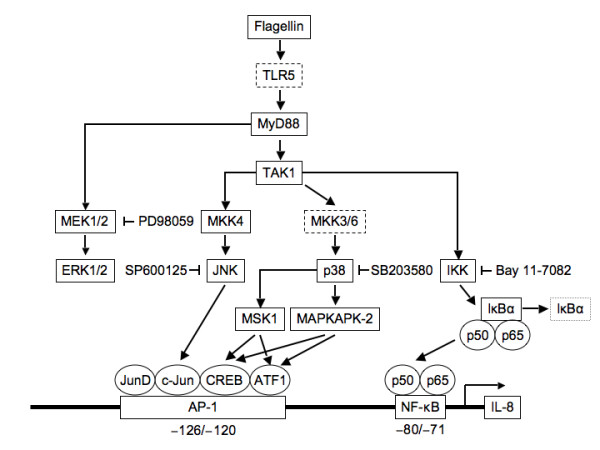
Schematic representation of L. pneumophila-induced signal transduction pathways involved in IL-8 expression human T cells. The contributions of TLR5 and MKK3/6 are deduced.